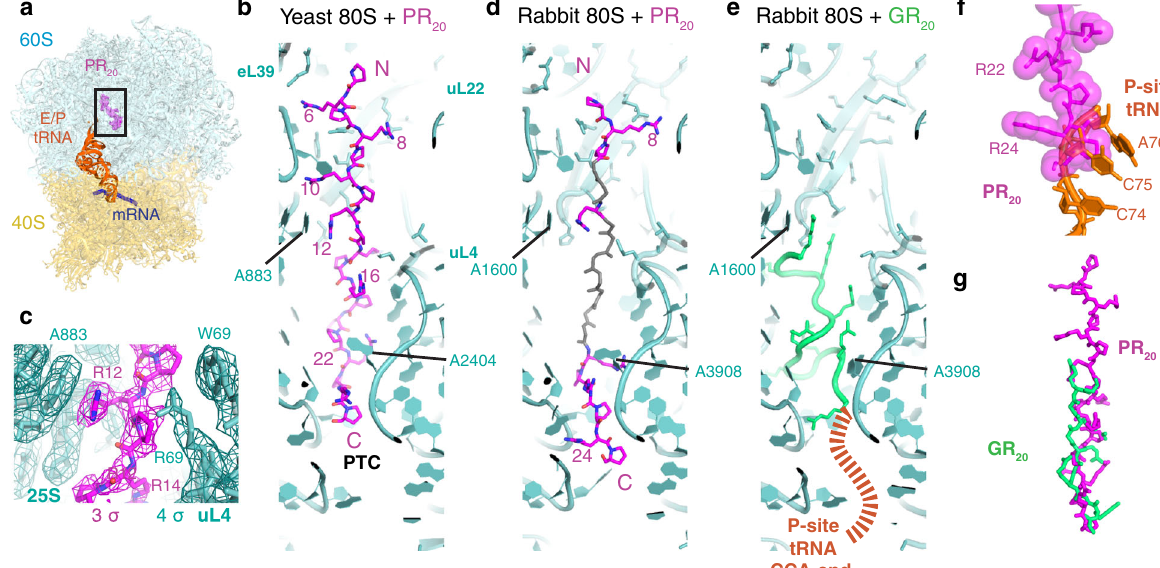
Fig. 4 PR 20 and GR 20 bind the polypeptide tunnels of eukaryotic 80S ribosomes. a Overview of the cryo-EM structure of yeast 80S • tRNA • PR 20 complex. b Cryo-EM structure of poly-PR (magenta) in the 80S tunnel (cyan); see also Supplementary Fig. 3 showing the fi t of the model to the cryo-EM densities. Peptidyl-transferase center (PTC), ribosomal proteins and nucleotides, and PR repeats are labeled. c Poly-PR and interactions at the tunnel constriction at 25S rRNA nucleotide A883. Cryo-EM map (mesh) was B-factor sharpened (-32 Å 2 ), fi ltered to 2.4 Å resolution, and is shown at 3 σ for PR 20 and 4 σ for the ribosome. d In the rabbit 80S ribosome, PR repeats (magenta) are well resolved at the constrictions near the PTC and uL22 and are connected by lower-resolution density (modeled as gray backbone; see also Supplementary Fig. 4f – i showing the fi t of the model to the cryo-EM densities). e In the rabbit 80S ribosome, GR repeats (green) bind near the PTC and stretch toward uL4 and destabilize binding of the CCA end of P-tRNA. f Steric clash between poly-PR and superimposed peptidyl-tRNA ((orange tRNA 3 ′ end, from PDB:5LZS), superimposed via 28S rRNA 99 ) on the rabbit 80S ribosome suggests poly-PR competes with P-tRNA for binding to the PTC. g Poly-GR occupies the same region of the peptide tunnel as poly-PR (rabbit GR vs. yeast PR structures are